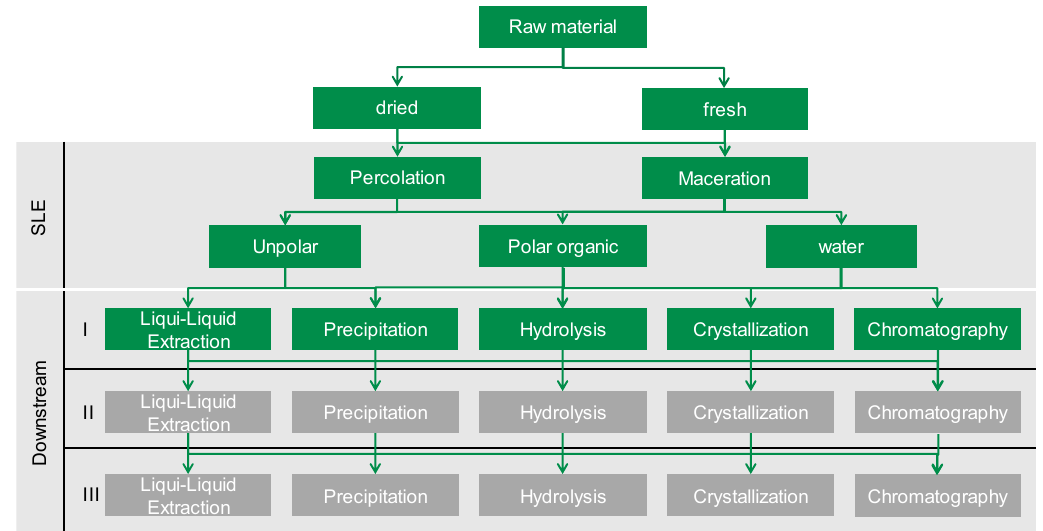
Figure 7. Development approaches for processing plant material. Solid–liquid extraction (SLE).